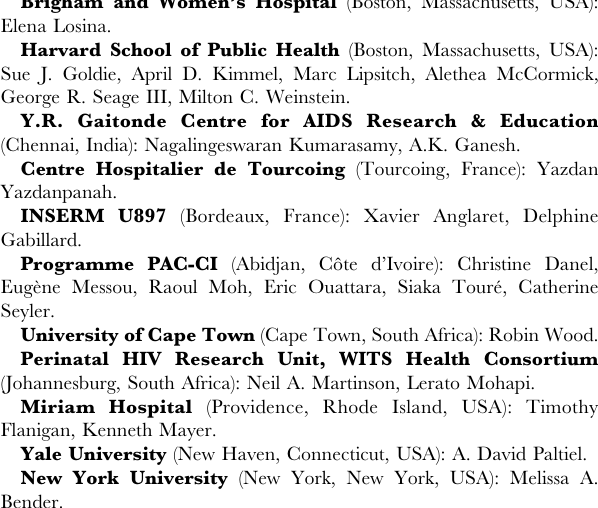
Table S2 Weighted cost and life expectancy by TB outcomes.